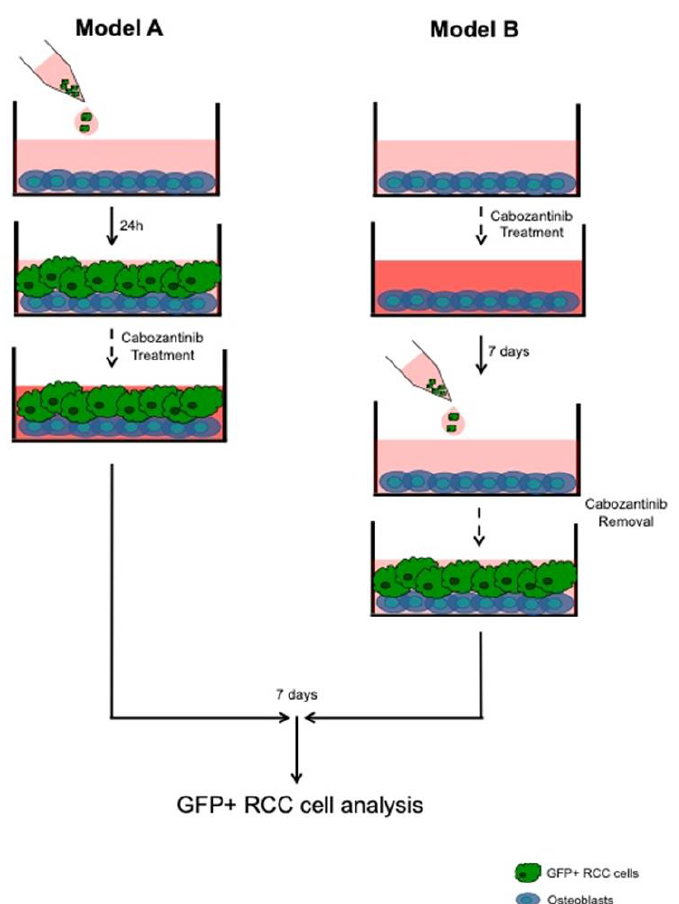
Figure 1. Representative schemes of OBs/RCC tumor cell coculture models. Model ( A ): 786-O GFP+ cells and GFP+ Caki-1 cells were seeded on an OB layer and treated or not with cabozantinib at 5 μM. After 7 dd, the GFP signal of the RCC cells was measured. Model ( B ): The OBs were treated or not with cabozantinib at 5 μM for 7 dd. GFP+ RCC cells were added, and the GFP signal was measured after 7 dd.